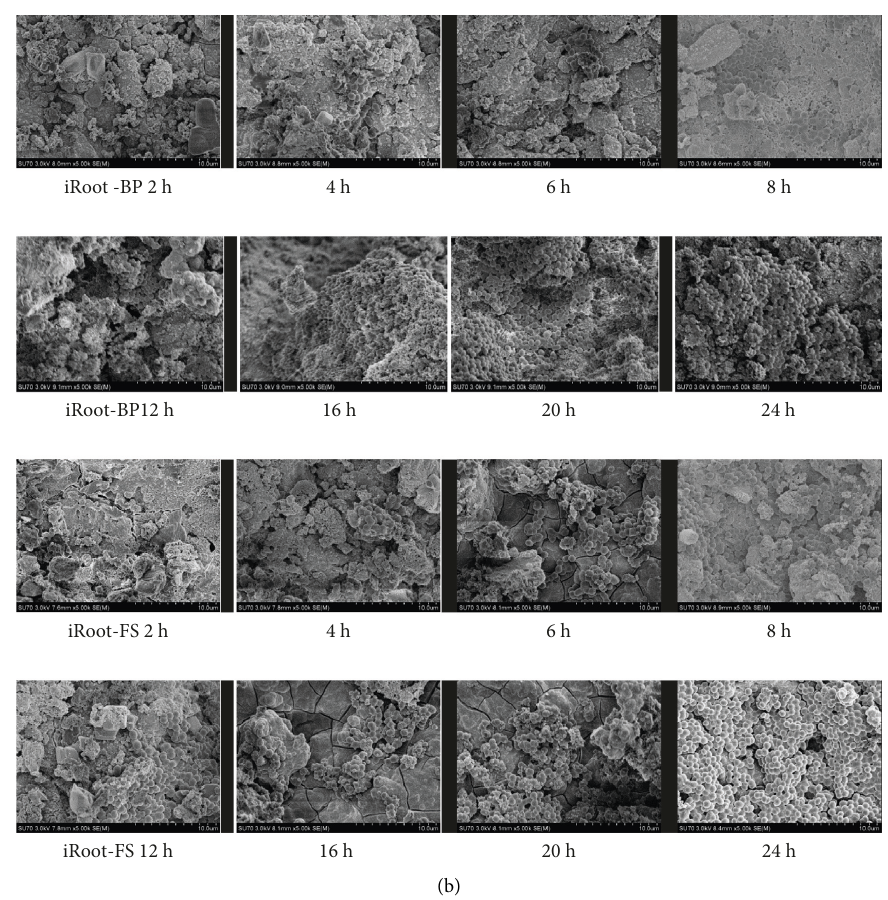
Figure 12: Electron microscopy pictures of the Enterococcus faecalis